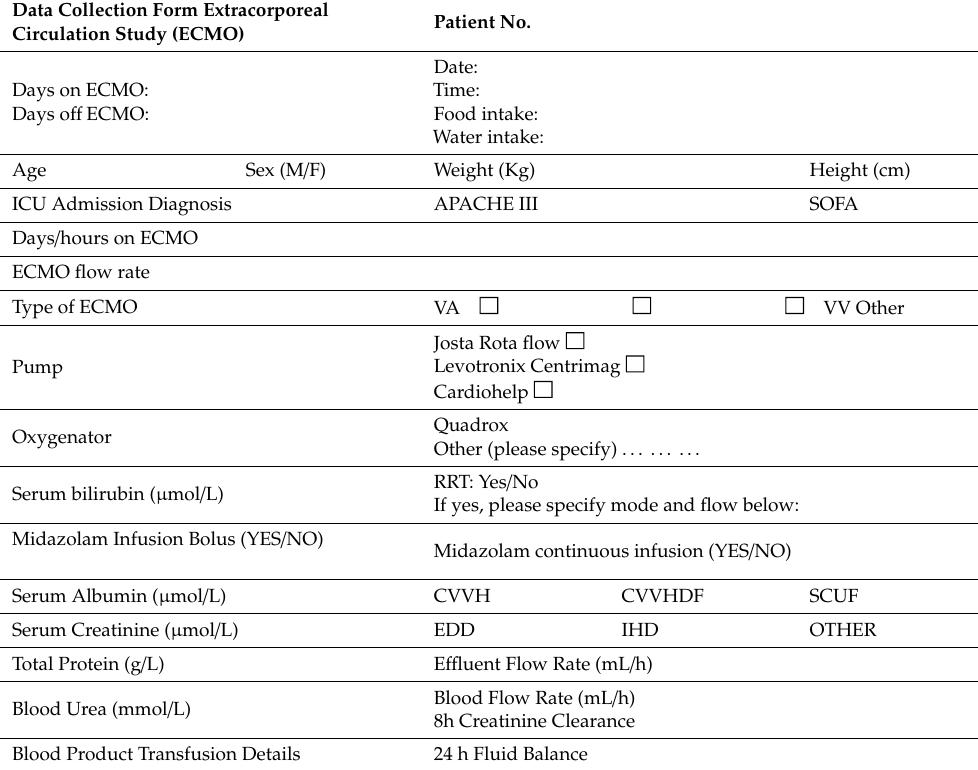
Table 2. Demographic and clinical collection form for patients on ECMO.